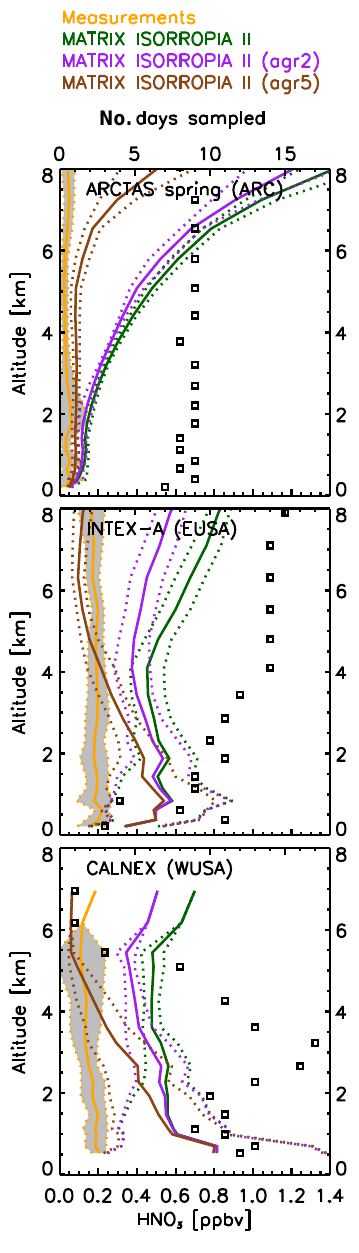
Figure A5. Mean regional HNO 3 profiles from the Arctic, EUSA, and WUSA. Measurements are in orange, MATRIX-ISORROPIA II with regular emissions is in green, with double agricultural NH 3 emissions in purple, and with 5 times higher agricultural NH 3 emis- sions in